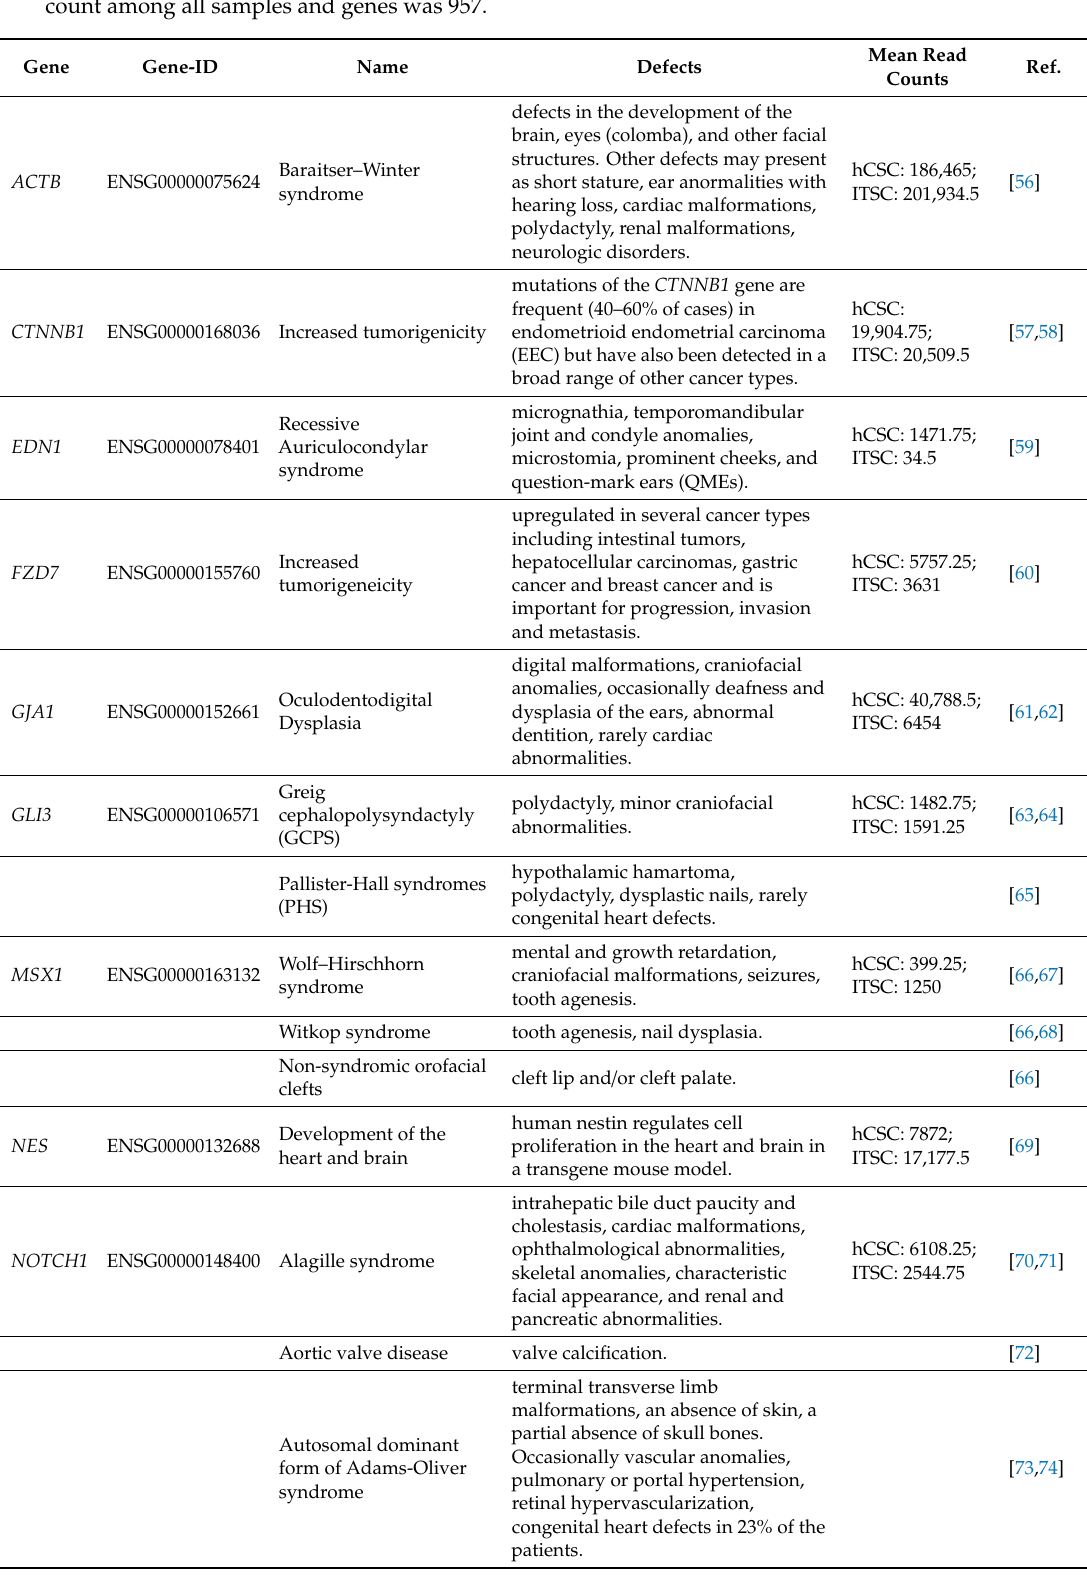
Table 1. Diseases related to mutations in neural crest-associated genes expressed in hCSCs and ITSCs. The read counts represent the mean of four replicates of hCSCs and ITSCs respectively. The mean read count among all samples and genes was